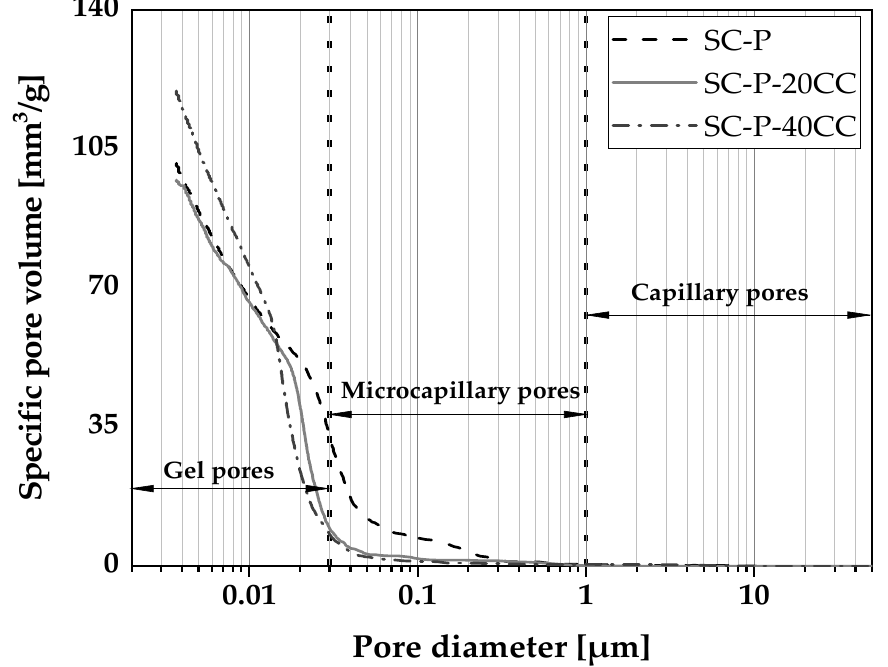
Figure 13. Pore size distribution of SC-P at 28 days of hydration. The compressive strength of SC-M was measured at ages of 2, 7 and 28 days (Figure 14a). Good correlations were observed between the 2 days compressive strength of the SC-M and its dynamic modulus of elasticity and hydration heat of the respective SC-P at 48 h, as shown in Figure 14b. At 2 and 7 days, the compressive strength values of the SC-M with CC were lower than that of the SC-M without CC due to the dilution effect by the CC. Nonetheless, the strength activity index of the SC-M with 20 and 40 vol.% CC at 7 days were 0.91 and 0.74, respectively, which was enough to consider the latter as SCM in concrete according to ASTM C311-18 [72]. At 28 days of curing, the pozzolanic reactivity of the CC led to the formation of more AFm phases and densification of the SC-M microstructure, as presented by thermal analysis and MIP. Consequently, higher values of compressive strength were achieved as depicted in Figure 14a. The strength activity index of the SC-M with 20 and 40 vol.% CC at this age were 1.08 and 1.07, respectively. as a cement replacement at an early age of hydration (2 days) led to the reduction of the compressive strength, and limited the precipitation of hydrate phases. At later age of hydration, namely 28 days, the pozzolanic reactivity of CC led to specific pore volume refinement and improved the compressive strength of the